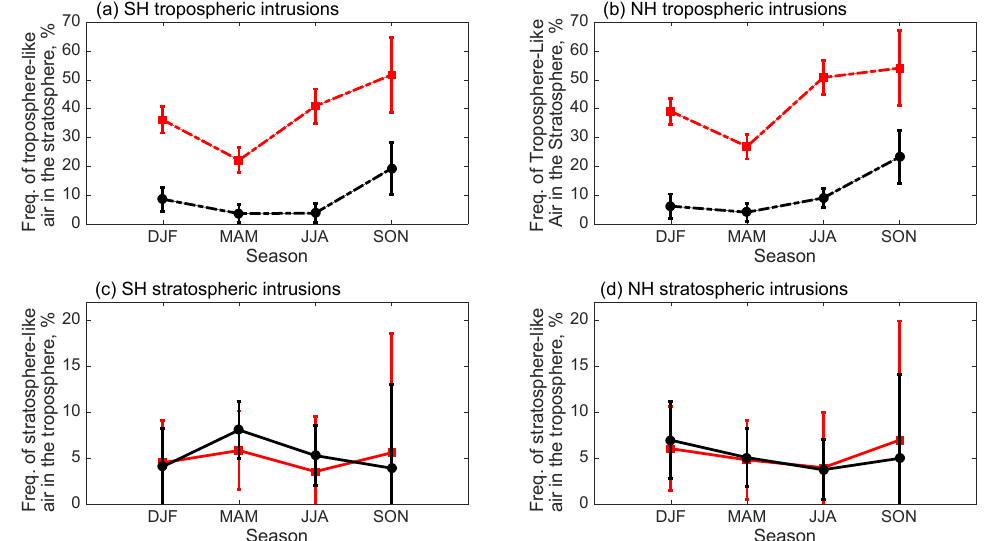
Figure 12. A seasonal representation of the intrusions depicted in Fig. 11: (a) tropospheric intrusions in the Southern Hemisphere, (b) tropo- spheric intrusions in the Northern Hemisphere, (c) stratospheric intrusions in the Southern Hemisphere, and (d) stratospheric intrusions in the Northern Hemisphere. Each season is an average of the extratropical intrusion frequency with error bars indicating 1 standard deviation of the seasonal mean. ACE-FTS intrusions are in red squares and CMAM30HR intrusions are in black circles. Note the seasonality represented may be impacted by the sampling of ACE-FTS and may not representative for the full